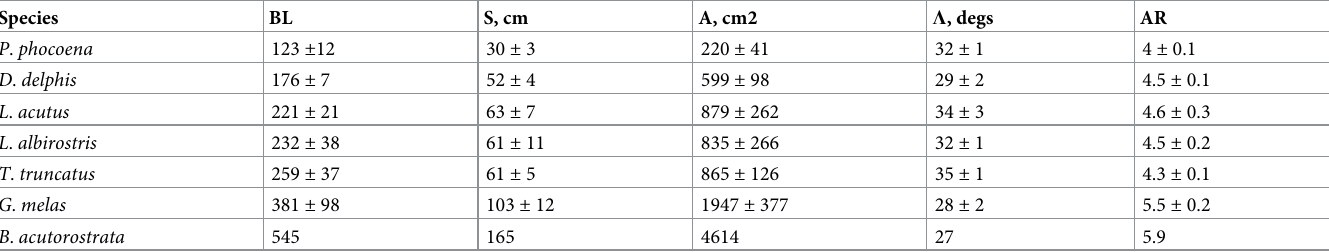
Species are ordered according to the body length BL.